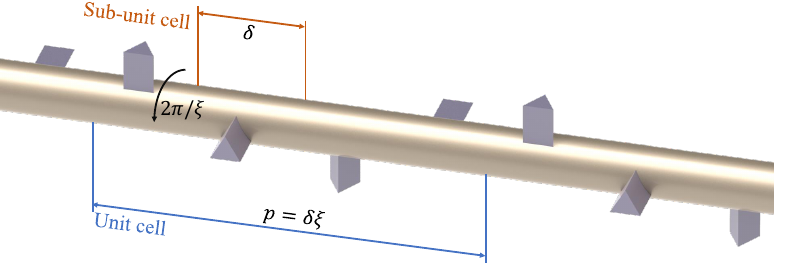
Figure 1. Illustration of a twist symmetry of order ξ = 4. The angle of the consecutive rotation here is π